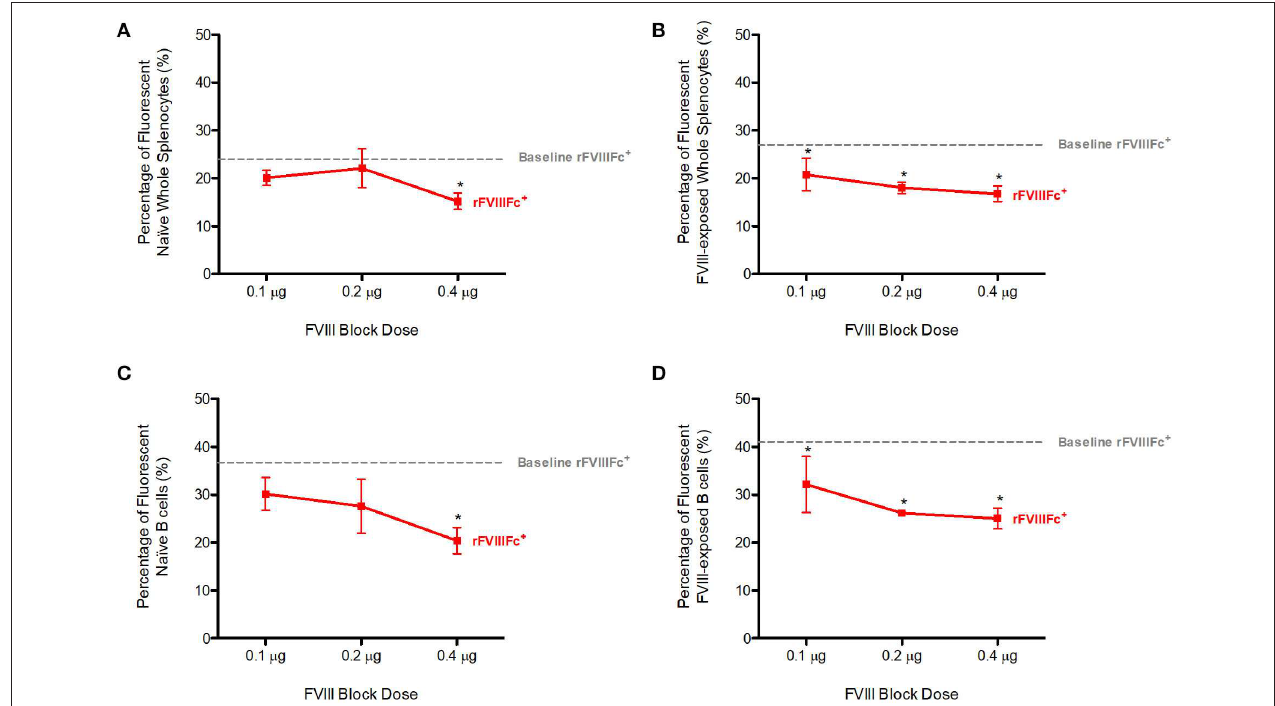
FIGURE 2 | Competition with FVIII decreases rFVIIIFc binding to naïve and FVIII-exposed splenocytes and B cells. The percentage of rFVIIIFc + (A) naïve whole splenocytes, (B) FVIII-exposed whole splenocytes, (C) naïve B cells, (D) FVIII-exposed B cells when blocking with FVIII (0.1, 0.2, or 0.4 µ g) prior to YFP rFVIIIFc (0.3 µ g) incubation. Baseline rFVIIIFc corresponds to the percentage of rFVIIIFc + cells in the absence of FVIII. Statistical analysis compares the percentage of rFVIIIFc + cells at all block doses against the same parameter at 0 µ g block. n = 3/condition. Error bars represent SD. * p <